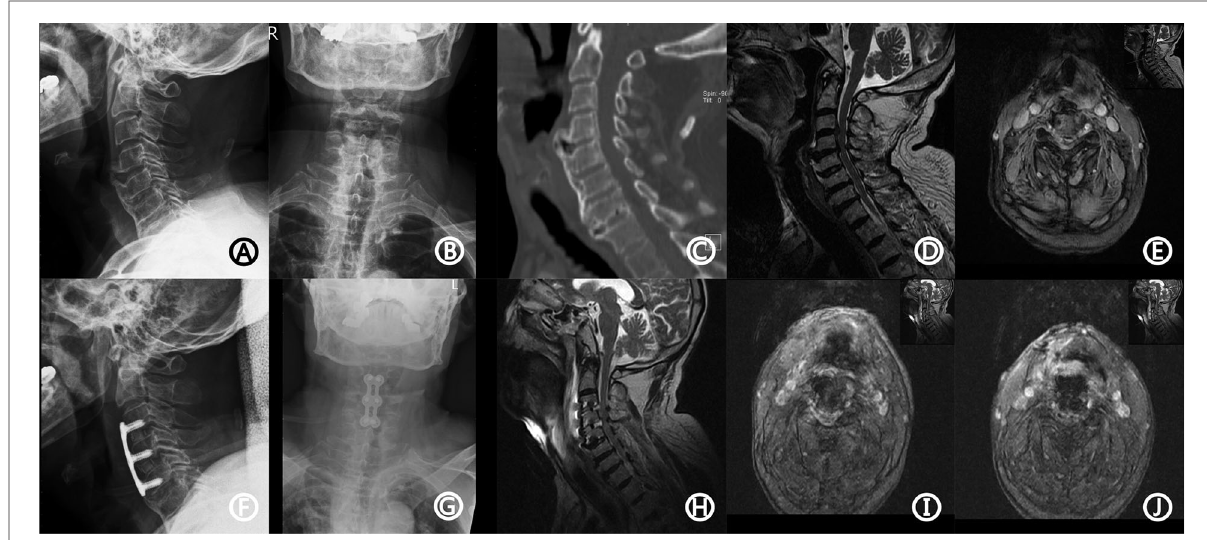
FIGURE 1 The patient ’ s imaging data. Preoperativex-ray showed degenerative changes ( A,B ). CT showed a bone bridge in the anterior part of the vertebral body ( C ). MRI showed disc herniation at the level of C3/4 and C4/5 vertebrae, causing compression of the spinal cord and corresponding spinal canal stenosis ( D,E ). Postoperative x-ray showed the good position of the plate and interbody ( F,G ). Emergency MRI showed low T1 and strip long T2 signal located behind C3/4 and C4/5 discs, and DPOSEH was suggested ( H – J ). CT, computed tomography; MRI, magnetic resonance imaging; DPOSEH, delayed postoperative spinal epidural